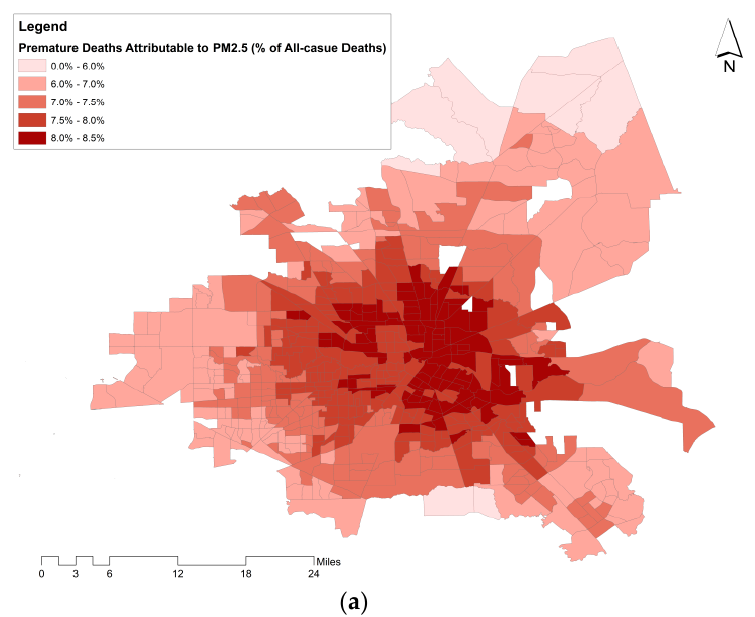
Figure 3. Range and distribution of estimated premature deaths attributable to PM 2.5 and NO 2 as a percentage from all ‐ cause deaths for zero ‐ exposure scneario .